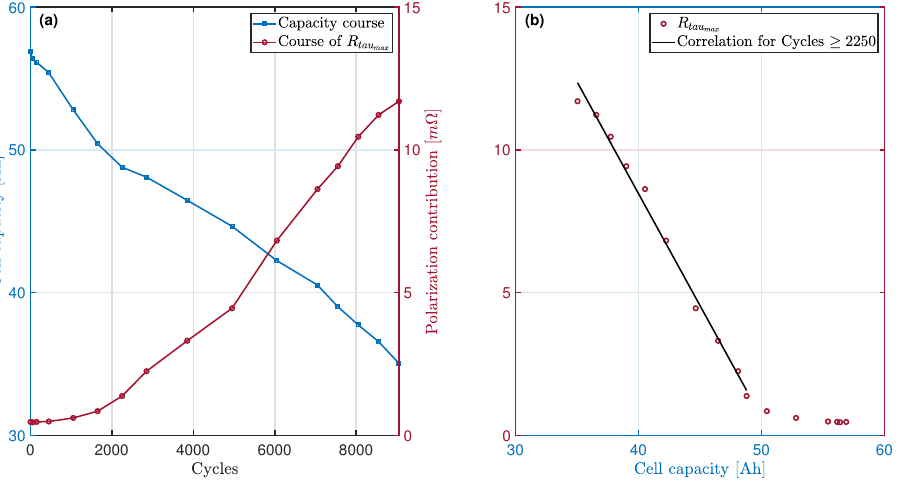
Figure 9. ( a ) Capacity course and polarization contribution R tau capacity and R tau max